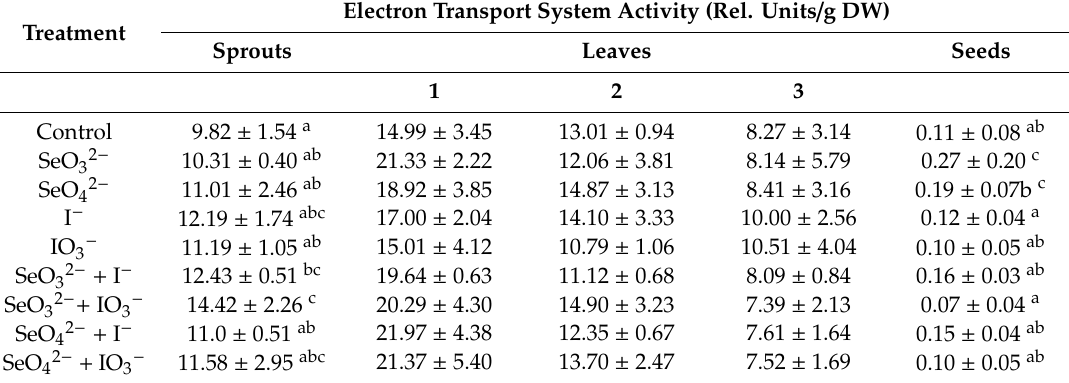
Table 4. E ff ects of the various seed and foliar treatments on the activities of the electron transport system in the pumpkin sprouts, leaves of mature plants and